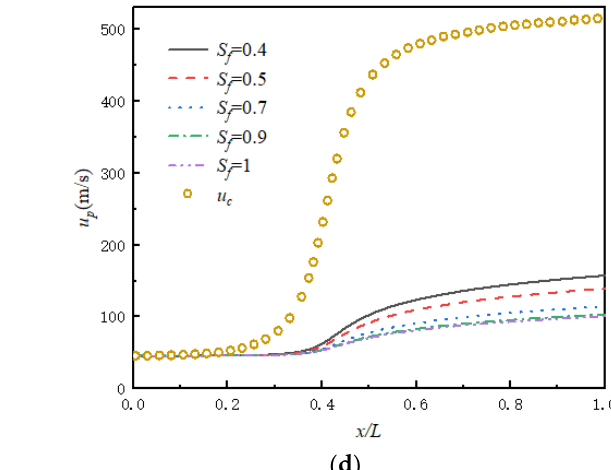
Figure 7. Velocity of particles along the micronozzle axis with different shape factors for: ( a ) d p = 0.3 µm; ( b ) d p = 0.7 µm; ( c ) d p = 1.6 µm; ( d ) d p = 4.5 µm.